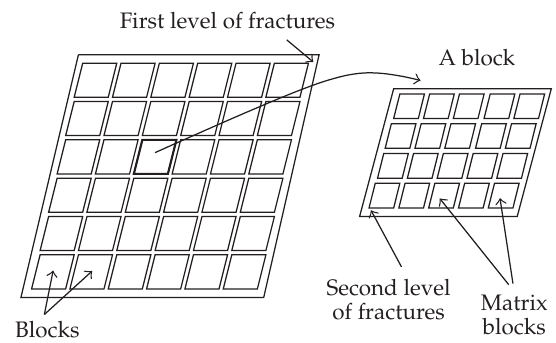
Figure 1.1 . The periodic structure in a reservoir exhibiting two lev- els of